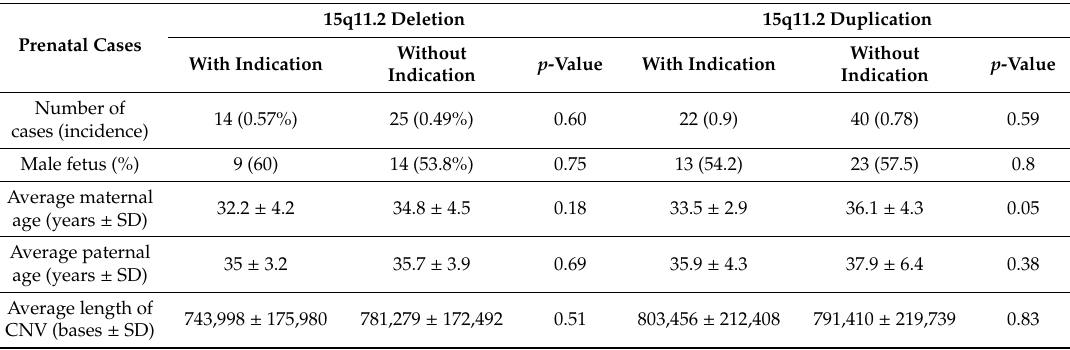
Table 3. 15q11.2 BP1-BP2 copy number variations detected prenatally.